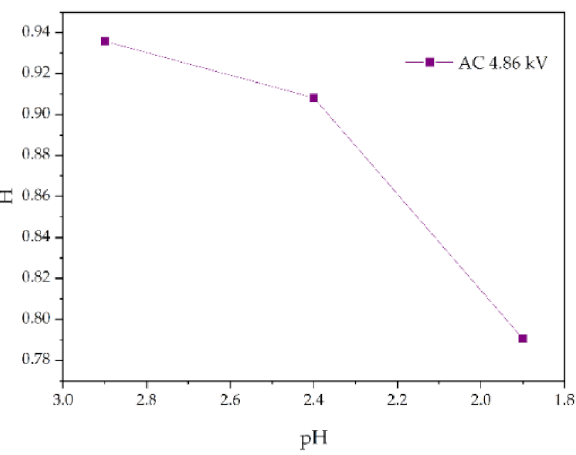
Figure 15. Changes in H values of samples with pH value (AC 4.86 kV, t = 8